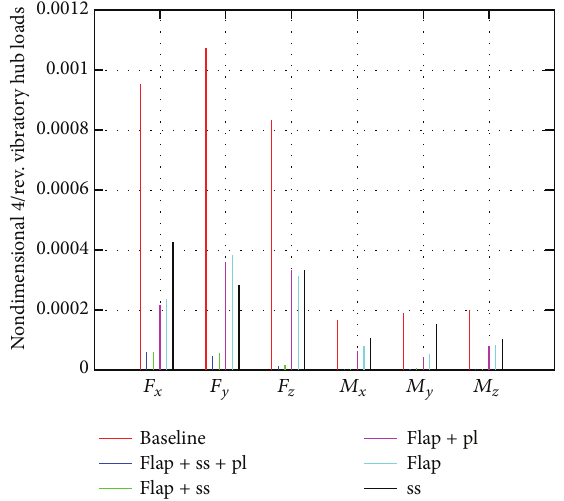
Figure 3: Hub loads, Drees wake inflow.